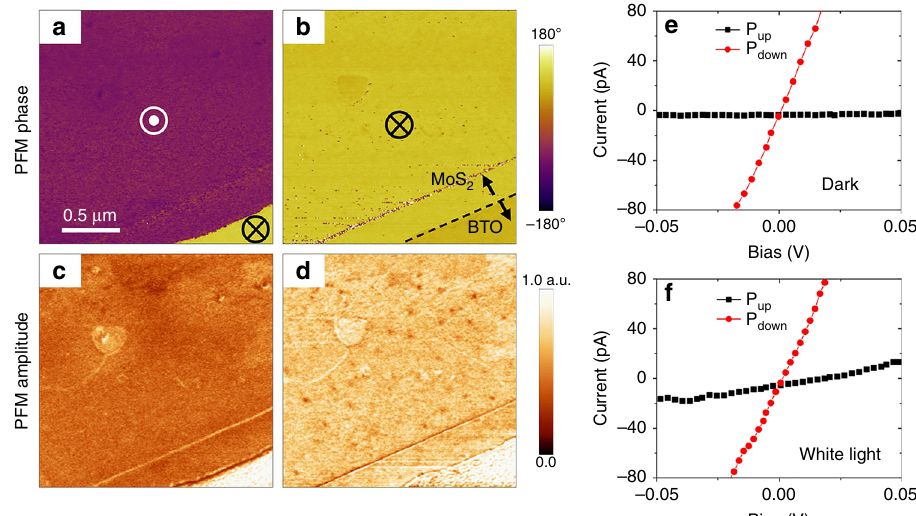
Fig. 1 Electrically induced polarization switching in the MoS 2 /BaTiO 3 /SrRuO 3 junction. a , b PFM phase ( a ) and amplitude ( b ) images after application of a negative voltage pulse ( − 5 V, 0.5 s) to the MoS 2 fl ake. The 12-u.c.-thick BTO fi lm underneath the MoS 2 fl ake is fully switched to the upward polarization, P up . c , d PFM phase ( c ) and amplitude ( d ) images after application of several positive voltage pulses ( + 5 V, 0.5 s) to the MoS 2 fl ake. BTO underneath the MoS 2 fl ake is fully switched to downward polarization, P down . The polarization state of the bare BTO fi lm (at the lower right corner) is not affected by the electrical bias. e , f The I – V characteristics of the same junction measured in the dark and during illumination. The tunneling current for the OFF state (P up